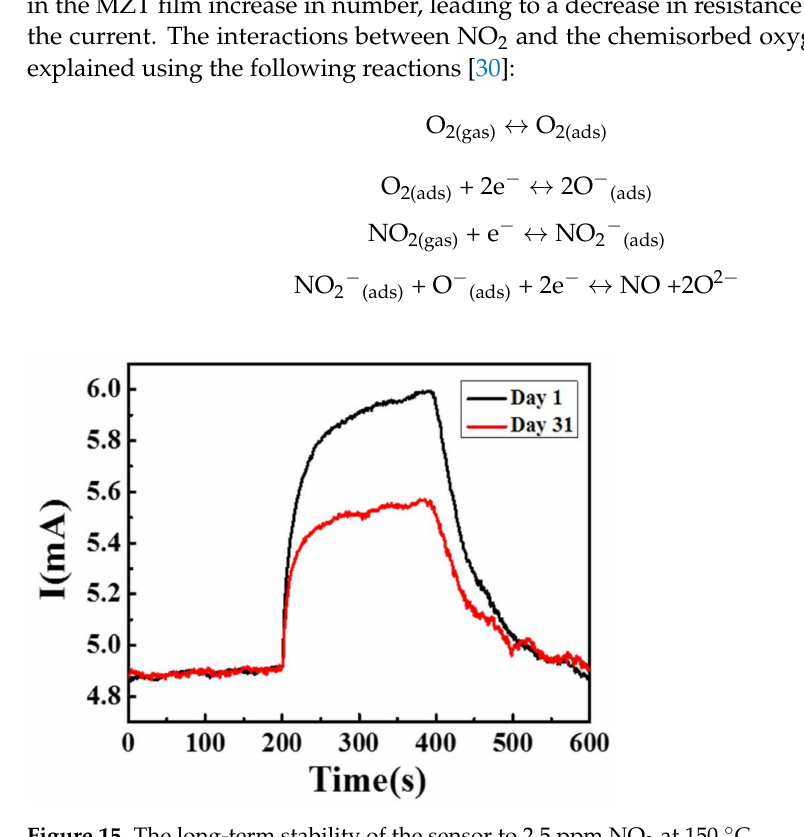
Figure 15. The long-term stability of the sensor to 2.5 ppm NO 2 at 150 ◦